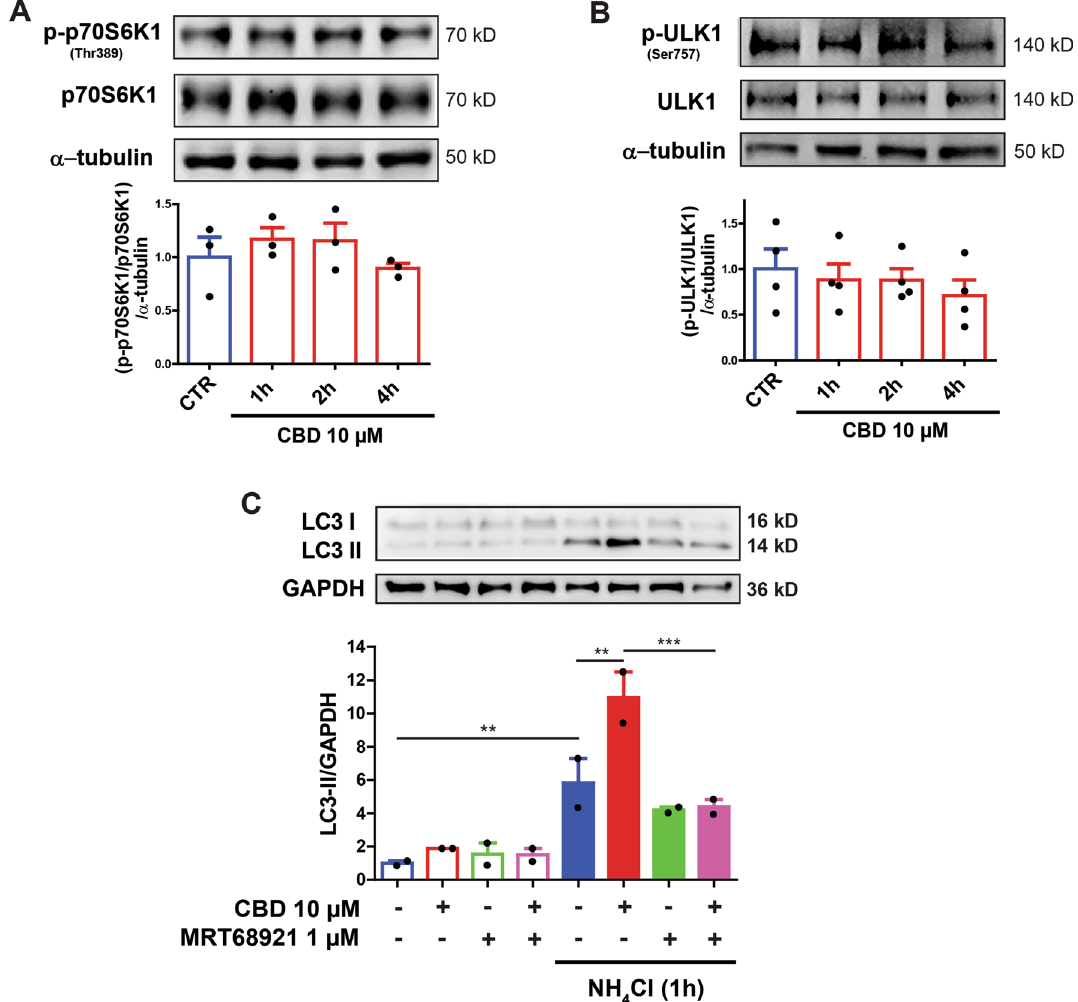
Figure 5. Role of mTORC1/ULK1 pathway on autophagy induction by CBD. ( A , B ) Total lysates from SH-SY5Y cells were treated with 10 µM CBD for 1, 2 and 4 h. The blots were incubated with a specific antibody for phosphorylated p70S6K1 (Thr389) and ULK1 (Ser757) or with an antibody that recognizes total p70S6K1 and ULK1. No effect was observed on the mTOR targets ( A ) p70S6K1 (Thr389) and ( B ) ULK1 (Ser757) after treatment with CBD, thus indicating that autophagy activation is independent of mTORC1. Data are expressed as means ± S.E.M., and data points are displayed as dots. The analysis was conducted with a one-way ANOVA followed by Dunnett’s post-hoc test. * p < 0.05, ** p < 0.01 relative to respective CTR group. ( C ) The autophagic flux was evaluated in SH-SY5Y cells pretreated with 1 µM of the ULK1/2 inhibitor MRT68921 for 30 min) and treated with 10 µM CBD for 2 h, in the presence or absence of the lysosome inhibitor NH 4 Cl, at the last hour of the treatment. The 10 µM CBD treatment increased LC3-II levels under NH 4 Cl blockade, which was abolished MRT6892 pre-treatment. Samples were subjected to western blotting using anti-LC3 and anti-GAPDH antibodies. Representative images of LC3-II are shown above the bar graphs. The bar graphs are reported as the means ± S.E.M of LC3-II levels after GAPDH normalization. Analysis was conducted with Three-way ANOVA followed by Sidak’s post-hoc test; * p < 0.05, ** p < 0.01 and *** p < 0.001. Full-length blots are presented in Supplementary Figure